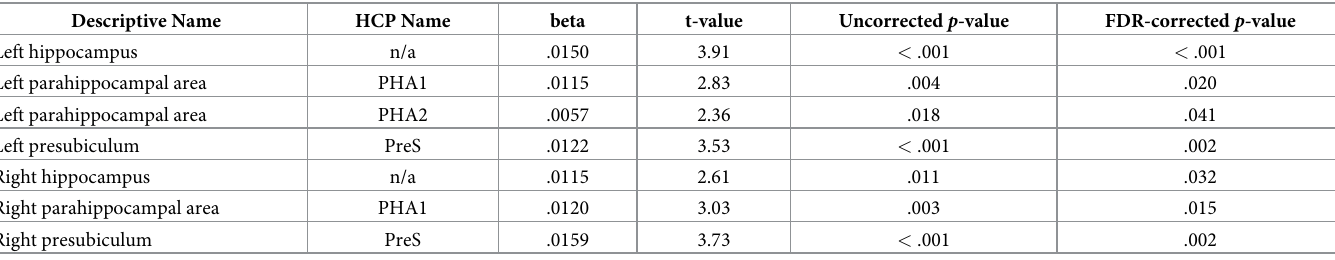
Table 3. Brain regions’ node strength significantly associated with verbal episodic memory test